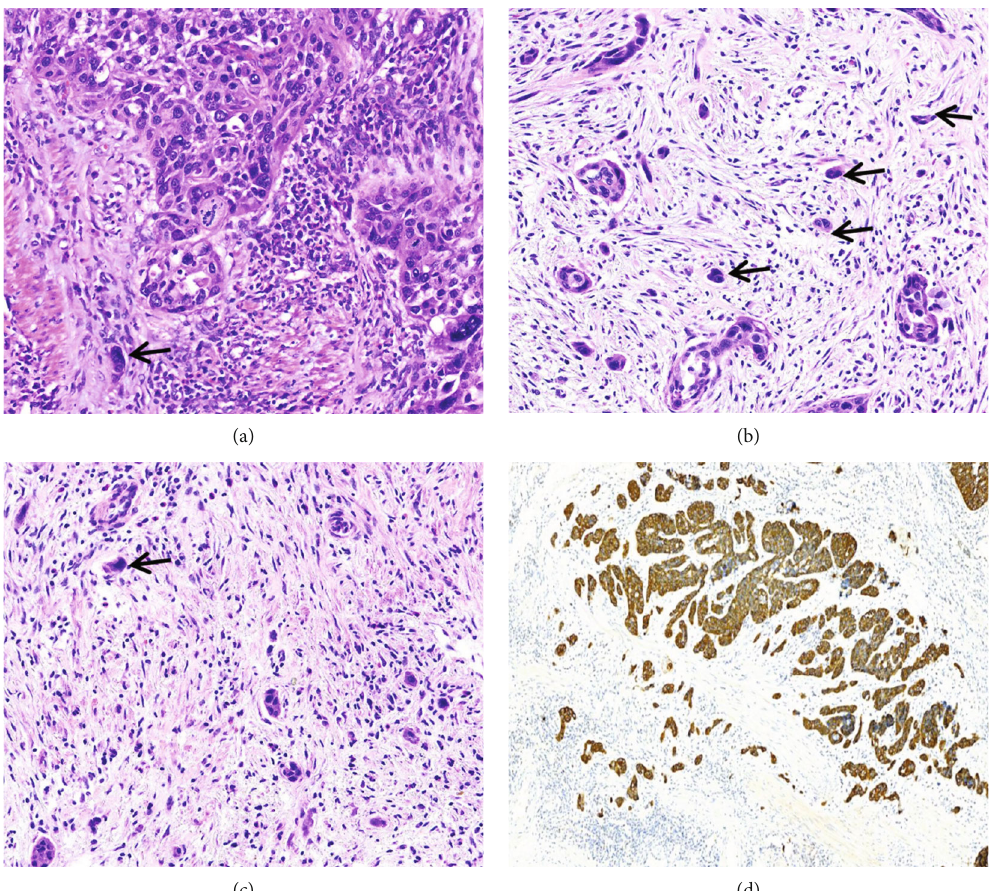
Figure 1: Morphologic features of ureter urothelial carcinoma (HE). (a, b) Tumor budding: (a) low budding and (b) high budding; (c) cell nest size: single-cell invasion; (d) CK immunohistochemical staining. Arrows represent tumor